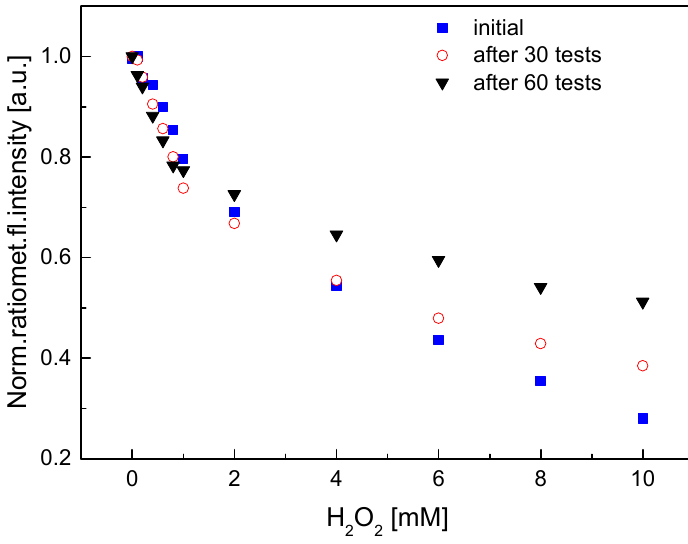
Figure 4. Lifetime of the QD–AF membrane.